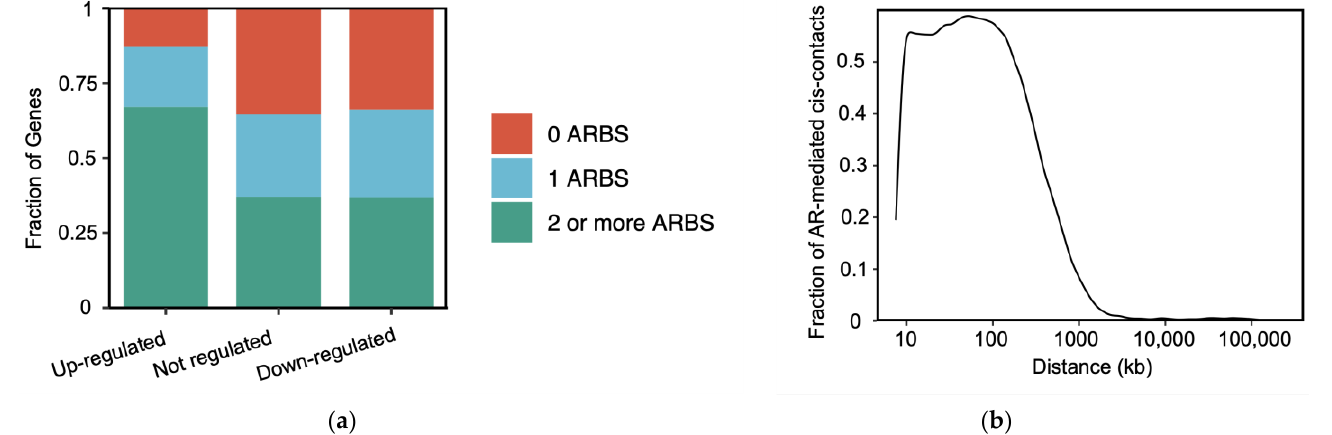
Figure 4. ARBS interaction landscape. ( a ) Multiple ARBS reside in close proximity to AR-regulated genes. Frequency of ARBS were quantified using publicly available androgen-induced RNA-seq [182] and AR ChIP-seq [183] from LNCaP cells. ( b ) AR ChIA-PET cis -contacts are mostly concentrated around 10 kb to 1 mb. AR-mediated looping dataset were used calculate the frequency of chromatin loops in VCaP cells [169].